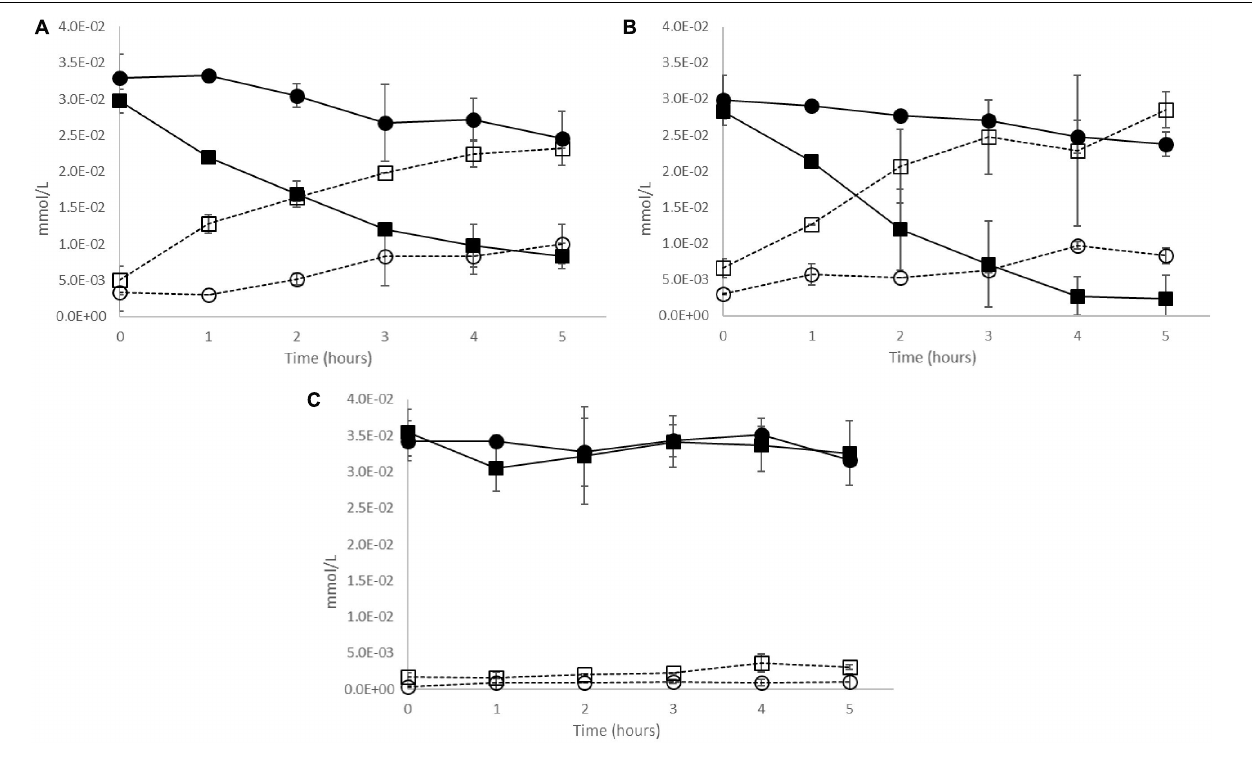
FIGURE 4 | Cinnamoyl esterase activity in live cultures of O. oeni CE+ strains (A) OenosTM, (B) CiNeTM, and (C) CH35TM previously grown in ( (cid:4) , (cid:3) ) wine-exposed or (